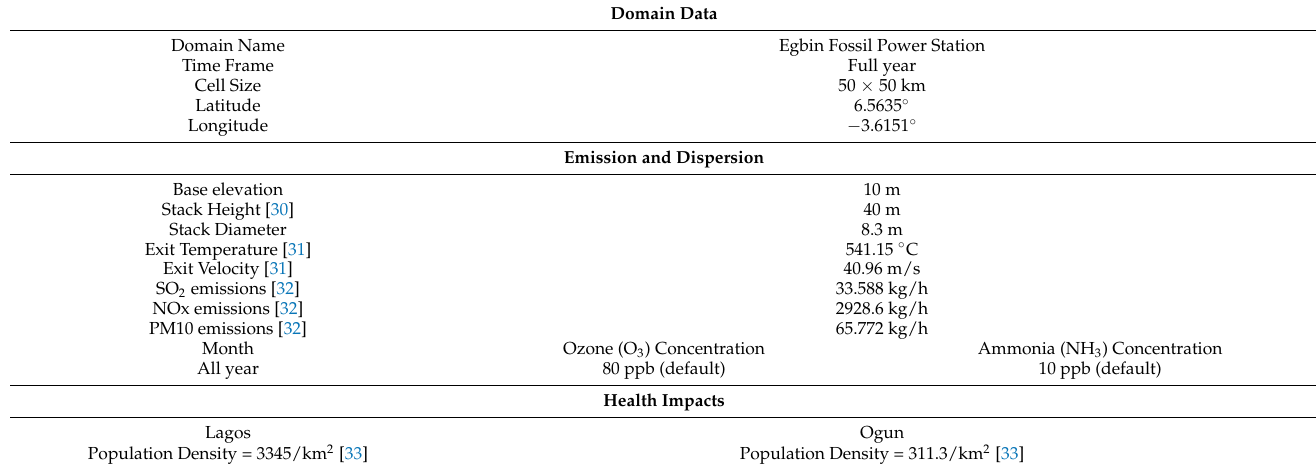
Table 3. Input data of Egbin fossil power plant simulated in SIMPACT code.